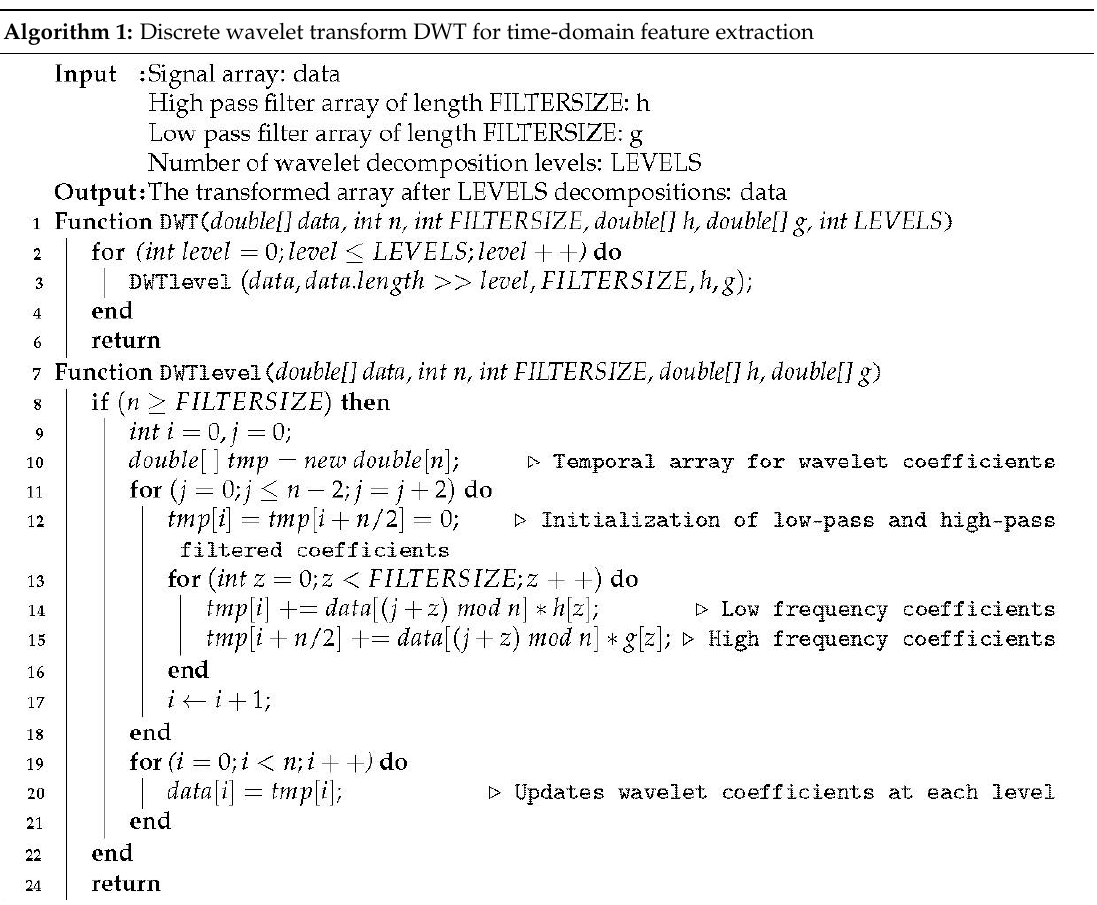
Sensors 2019 , 19 , x FOR PEER